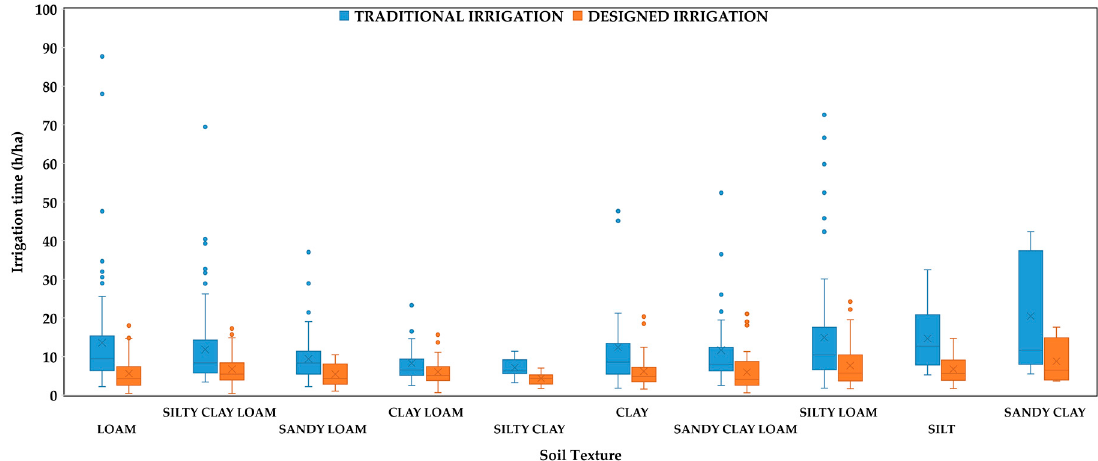
Figure 3. Irrigation time by textural class.